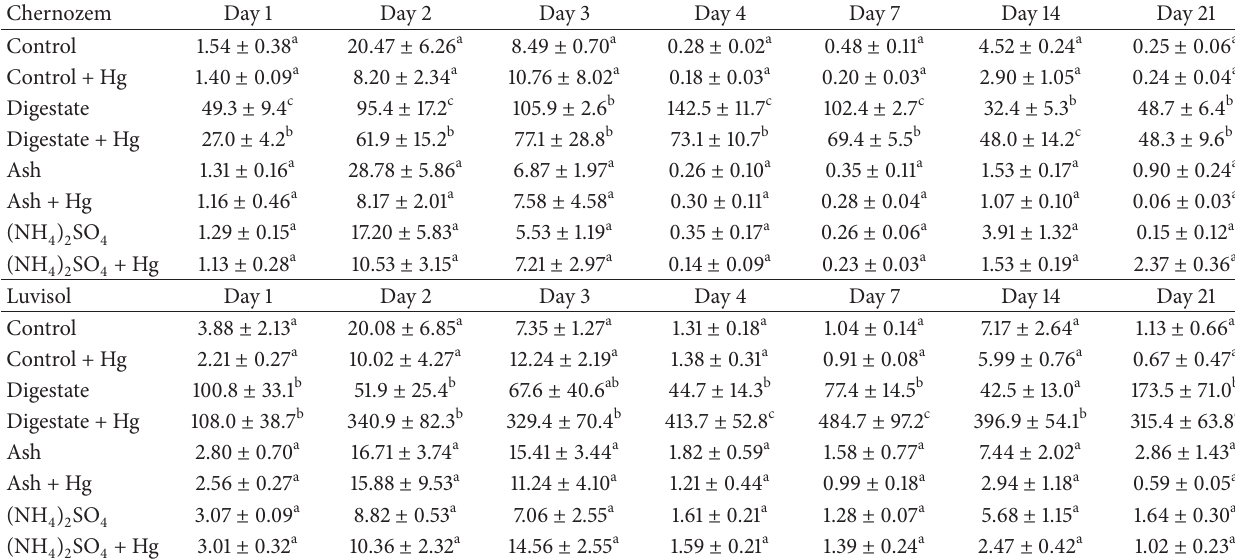
Table 7: The concentrations of Fe extractable with 0.11 molL − 1 acetic acidwithin the incubation experiment (mg ⋅ kg − 1 ); The averages marked by the same letter did not significantly differ at 𝑃 < 0.05 within individual columns; data are presented as mean ± standard deviation ( 𝑛 = 3 ).